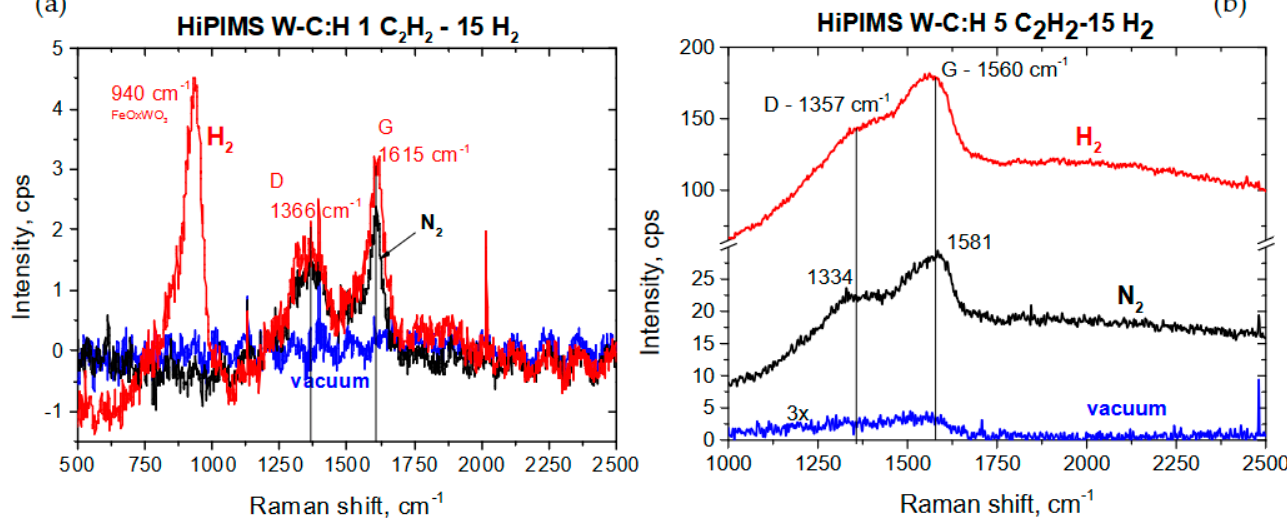
Figure 18. Raman spectra in transfer layers in ( a ) W-C:H 1C 2 H 2 -15H 2 and ( b ) W-C:H 5C 2 H 2 -15H 2 coatings after sliding in dry H 2 , dry N 2 and vacuum environments for 360 m, respectively. Note very small intensities in Figure 17a; the intensities of the signal in vacuum in Figure 17b were 3× magnified for better visibility.